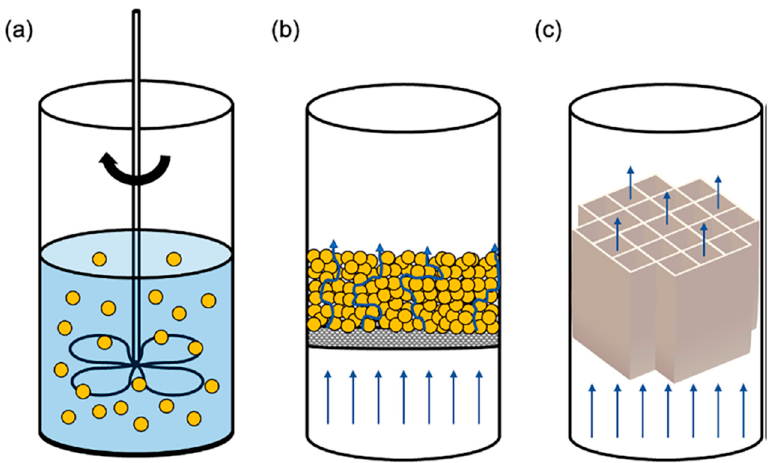
Figure 2. Three major categories of solid–fluid reactors utilized in microwave heating: ( a ) Slurry reactor; ( b ) Fixed bed reactor; ( c ) Structured bed reactor. Reprinted from [18].